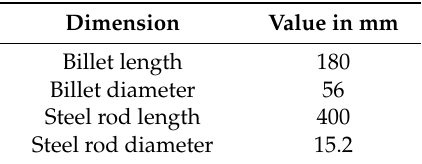
Figure 1. ( a ) 2.5 MN extrusion press (Müller engineering GmbH, Todtenweis, Germany); ( b ) Longitudinal section of LACE tool and container. Table 1. Billet and steel rod dimensions.